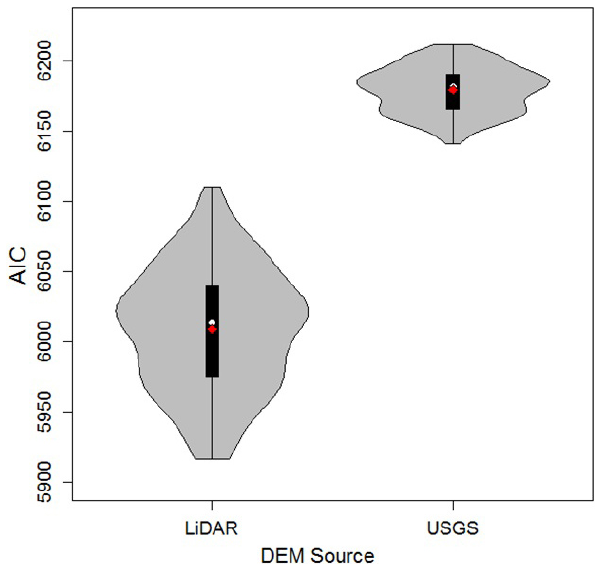
Figure 2. Violin plot of AIC values of the lidar and USGS DEM source groups. The median and mean are indicated by the white dots and red diamonds, respectively; the interquartile range is indi- cated by the thick vertical bar, the density distribution is shown as the symmetrical (mirrored) grey area and highlights the peaks and valleys of the AIC distribution.